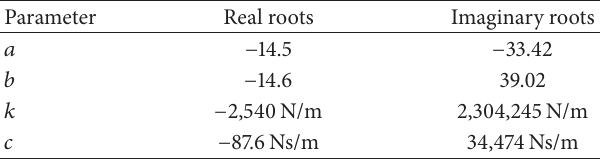
Table 2: Damper and spring constants for Maxwell model.